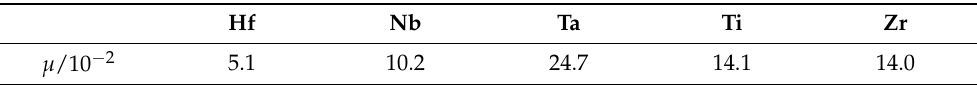
Figure 2. APT analysis of homogenized HfNbTaTiZr: ( a ) Reconstruction of an atom probe tomography (APT) tip showing 2% of all ions. ( b ) Same sample volume showing 2% of all Ta ions as well as the 14 at.% isoconcentration surfaces of Ta. Ta-enriched regions are highlighted by arrows. Both reconstructions are displayed at the same magnification. Red-colored frame highlights region for concentration profile evaluation. ( c ) Concentration profiles x Ta and x Zr of Ta and Zr. Red arrows as well as two vertical, dotted lines that connect element concentrations at the same distance indicating the opposite concentration trends of both elements. Table 2. Autocorrelation factor µ for all elements determined from the entire sample volume, as shown in Figure